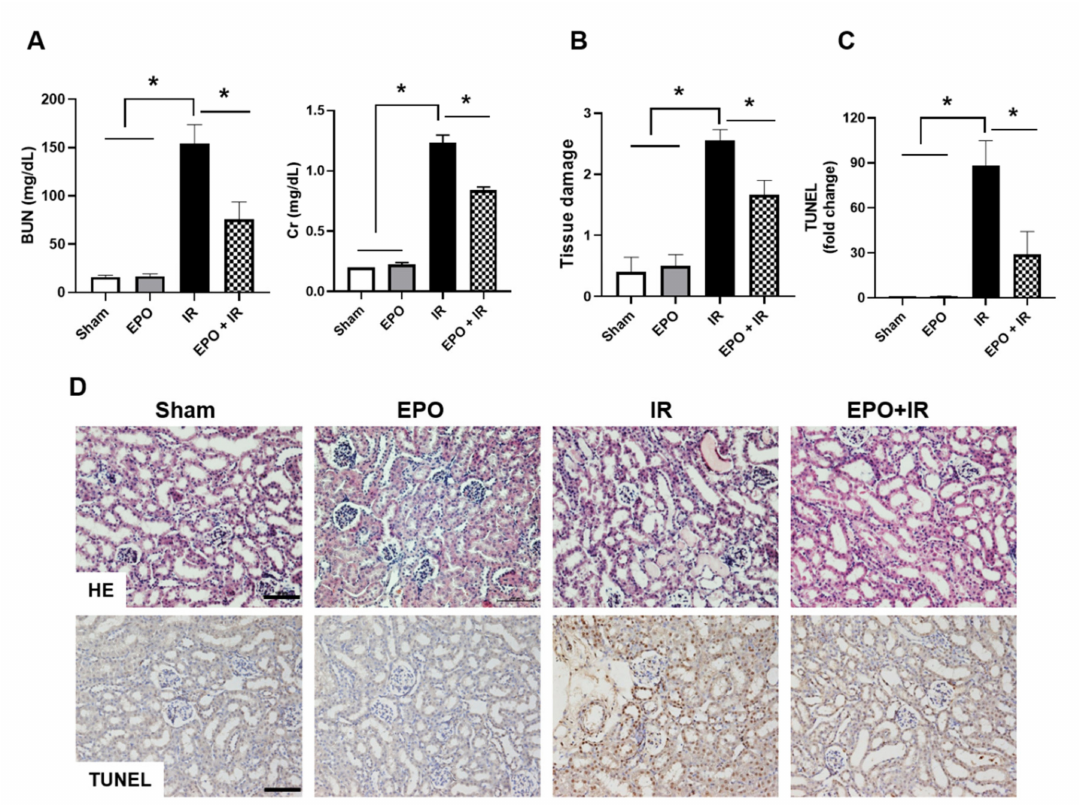
Figure 1. E ff ects of Erythropoietin (EPO) administration on renal function and morphological changes in IR-AKI. EPO (500 IU / kg body weight) was administered into the tail vein. Mice were sacrificed 24 h after ischemic injury for blood and kidney sampling. The serum blood urea nitrogen (BUN) and serum creatinine (Cr) levels were measured ( A ), and histological changes and renal apoptosis were examined by H&E staining and TUNEL assay, respectively ( B–D ). Tissue damage was quantified as described in ( C ). Scale bar, 100 µ m. Data are means ± SEM. * p <